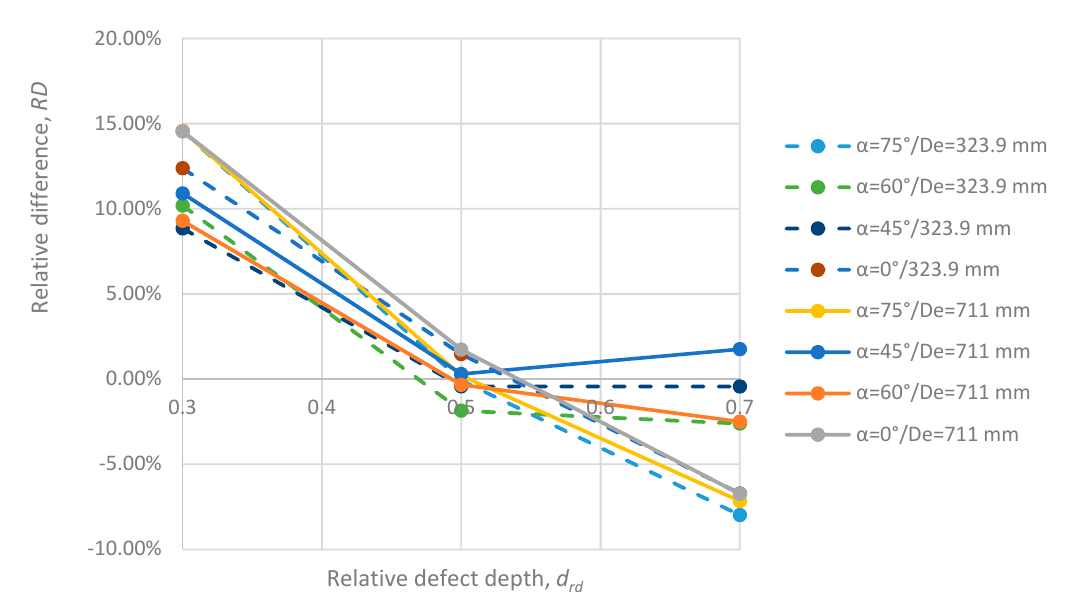
Figure 15. Relative difference, RD , between the maximum equivalent von Mises stress value and the allowable stress limit, for both pipes and type III composite.